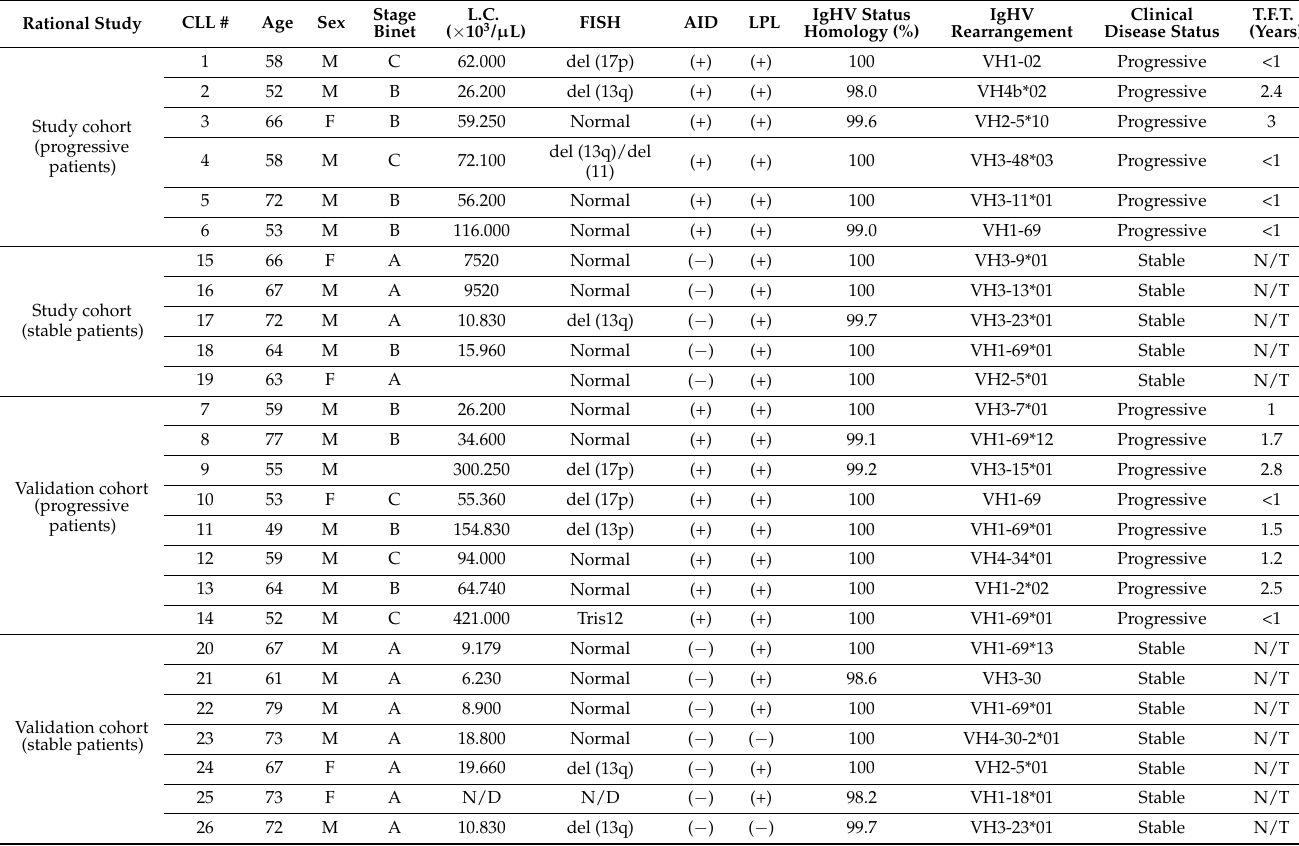
Table 1. Clinical and molecular characterization of CLL patients, AID and LPL expression assessed by q-PCR as described in [34,35]. T.F.T = Time from initial diagnosis to first treatment for clinical progression. L.C. = Lymphocyte Count. N/D = no determinate; N/T = not treated: Refers to patients who did not receive any treatment at 4 years